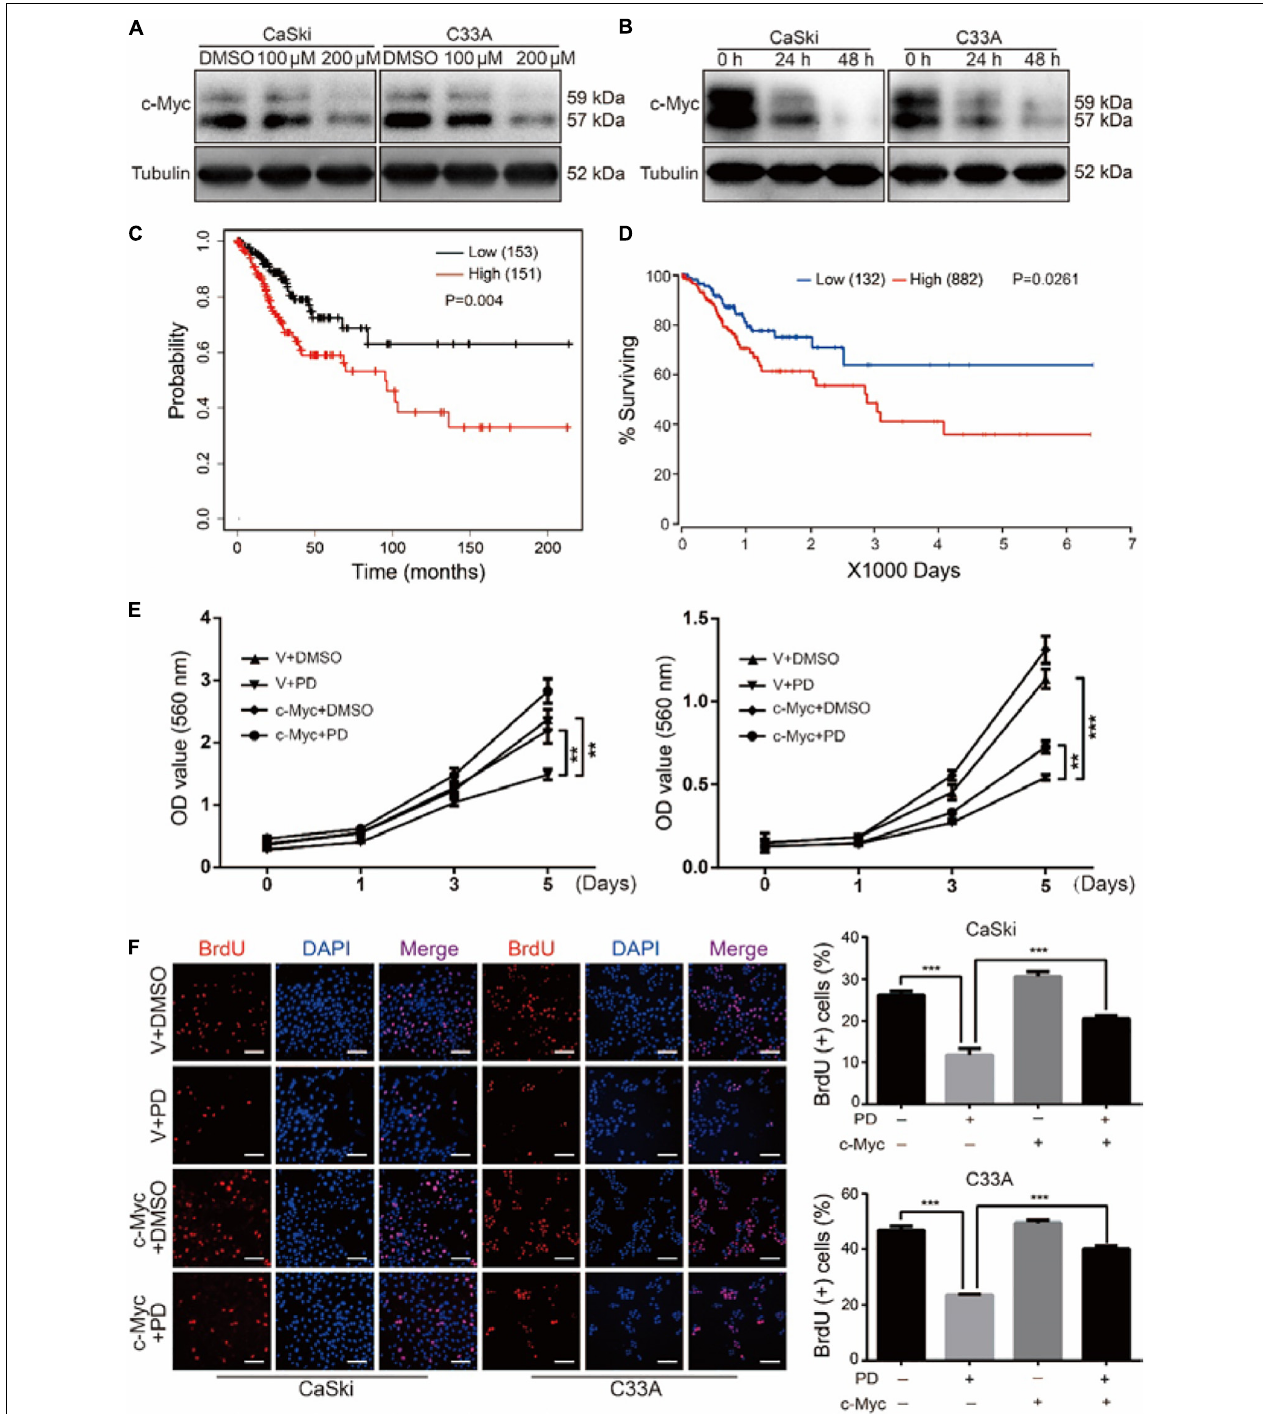
FIGURE 4 | Polydatin inhibits cell growth and proliferation through suppressing the c-Myc expression. (A,B) Western blot assays were used to show the expression of c-Myc after dimethyl sulfoxide (DMSO) or polydatin treatment. Cells were treated with polydatin at indicated concentrations or at indicated time. Tubulin was used as a control. (C,D) Kaplan–Meier overall survival for c-Myc expression in cervical cancer tumors (KM plotter dataset and OncoLnc dataset). (E) The effect of DMSO or 200 µ M of polydatin on the viability of c-Myc/vector-overexpressed CaSki and C33A cells using MTT assays. (F) Image and quantification of c-Myc-overexpressed CaSki or C33A cells as well as vector cells positive for BrdU staining after treating with DMSO or 200 µ M of polydatin for 48 h. Scale bar, 100 µ m. All data were analyzed using two-tailed Student’s tests. Error bars, ∗ P < 0.05, ∗∗ P < 0.01, and ∗∗∗ P < 0.001.